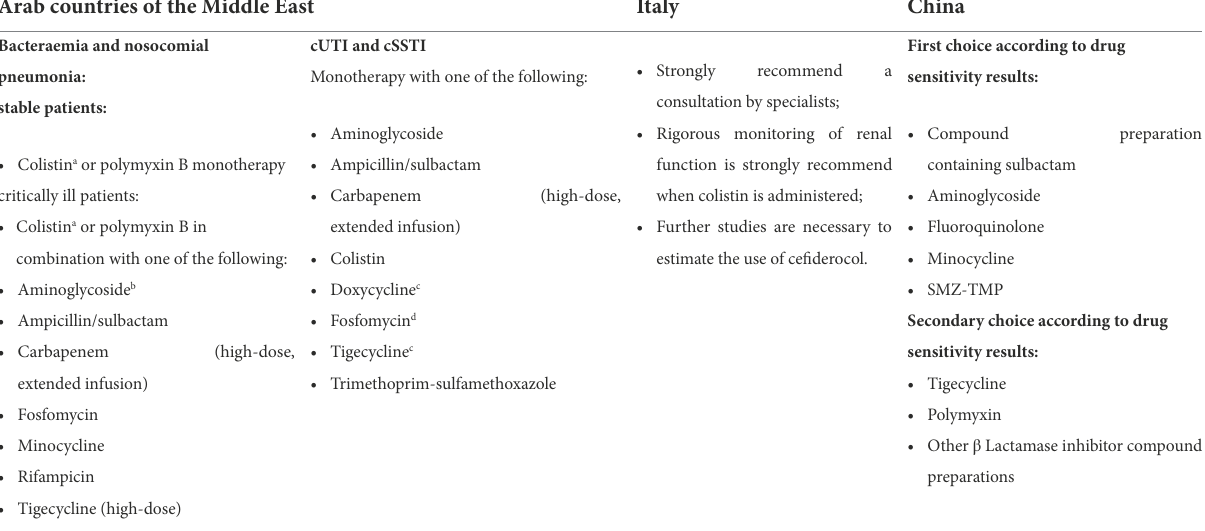
TABLE 2 Overview of the recommendations for antimicrobial treatment of CRAB infections in Arab countries in the Middle East, Italy, and China. Arab countries of the Middle